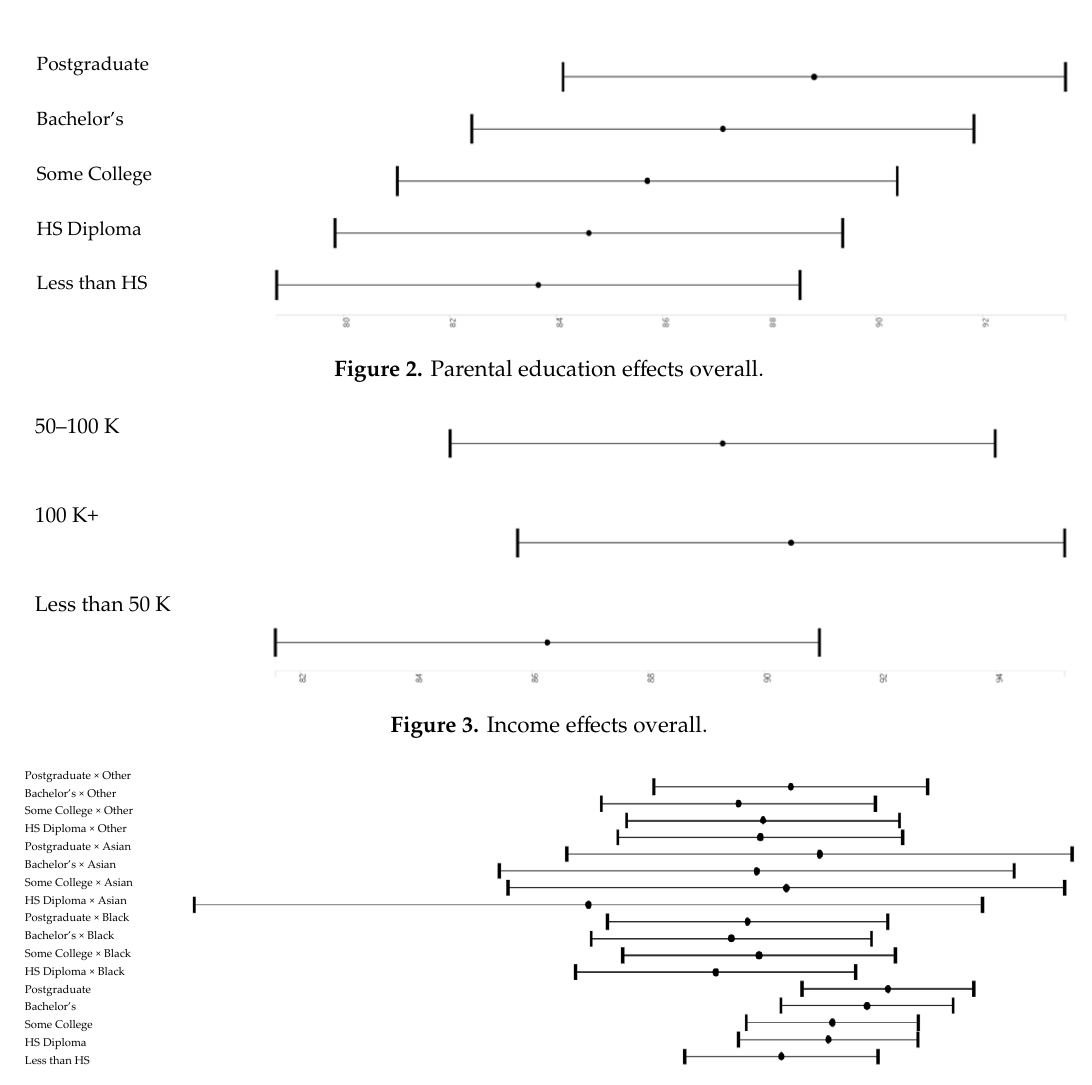
Figure 3. Income effects overall.